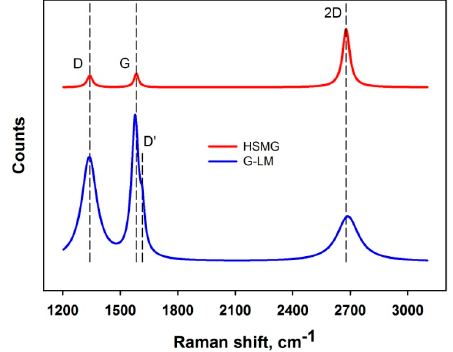
Figure 7. Raman spectra of single layer of high strength metallurgical graphene (HSMG ® )—red curve and metallurgical multi-layered graphene-like material (G-LM)—blue curve.